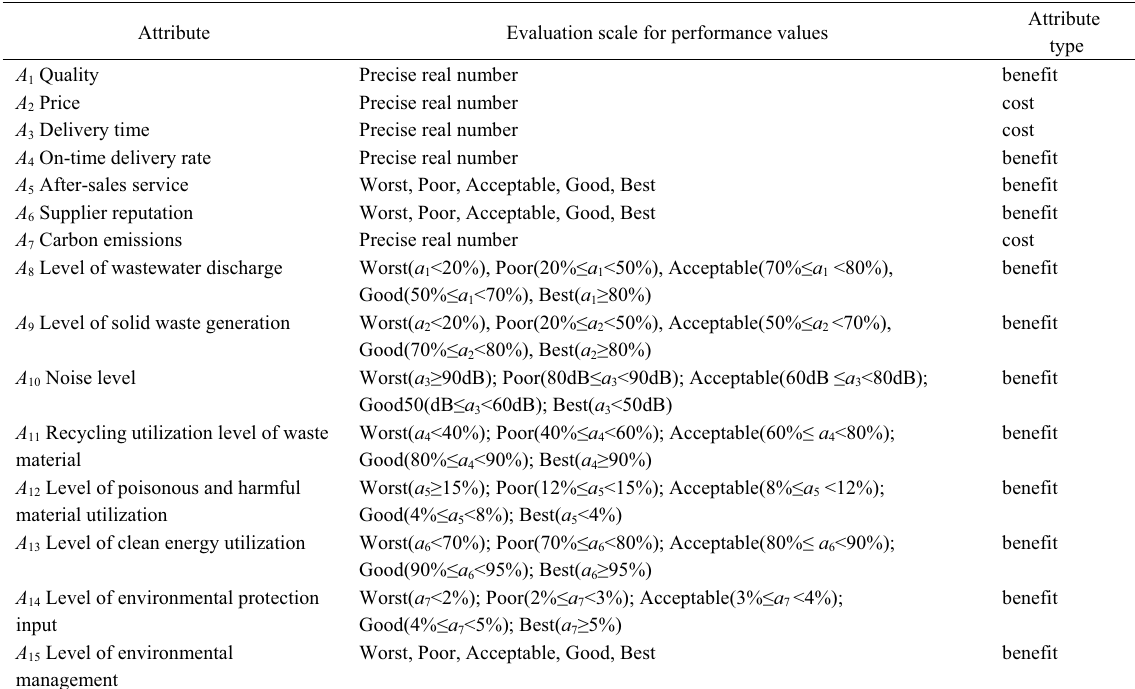
Table 2: Scale and type for evaluation